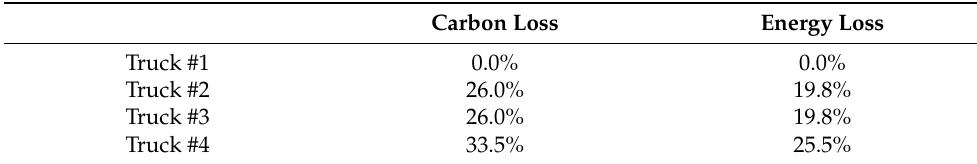
Table 4. Average carbon and energy